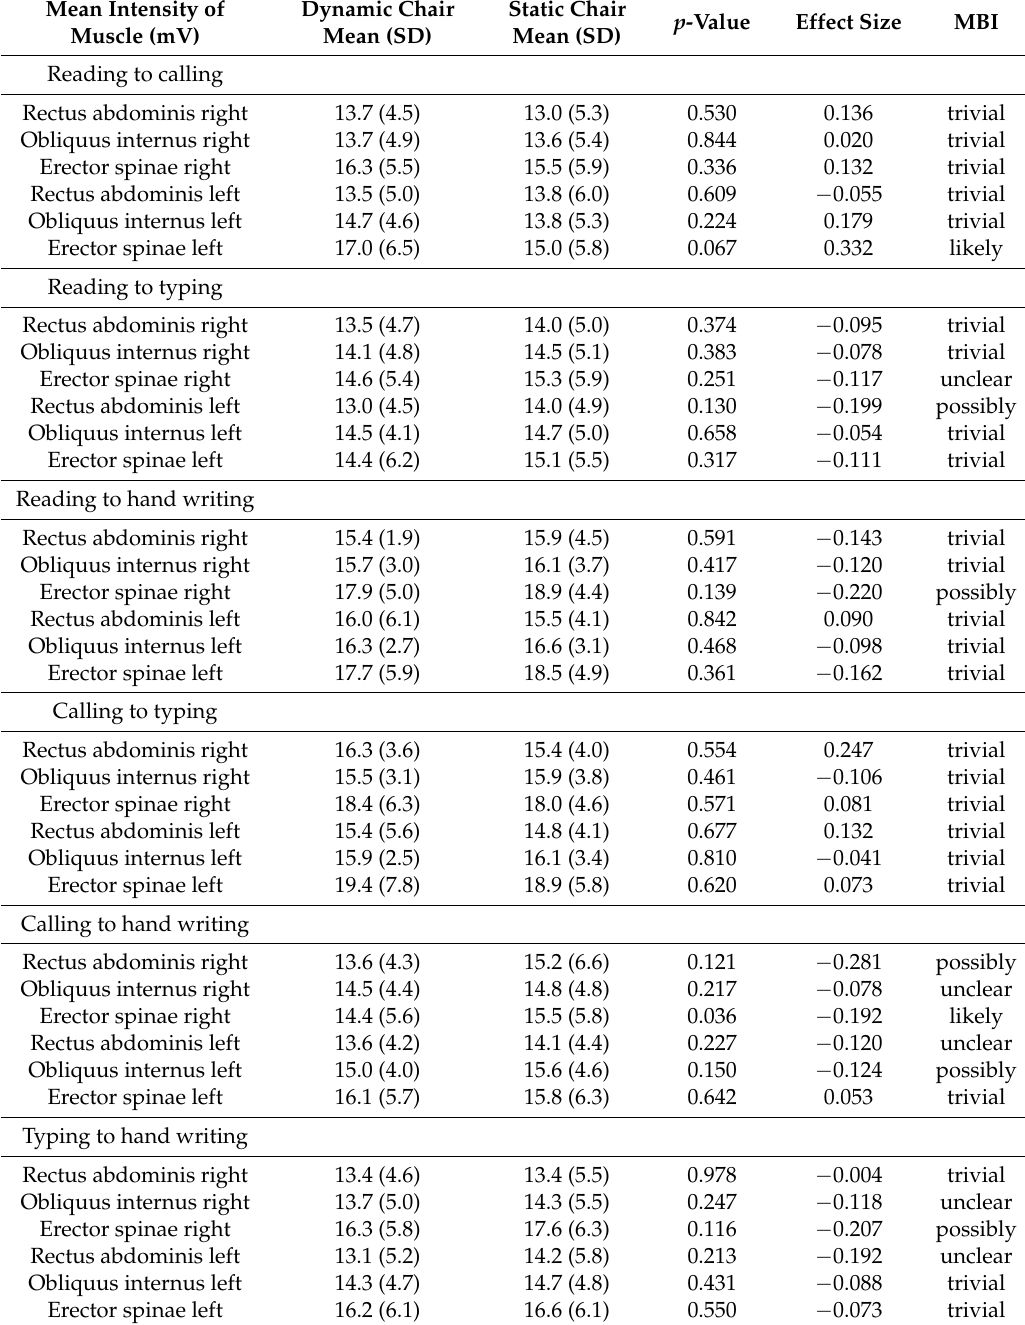
Table 3. Mean (SD) mean muscle intensity while sitting on the two chairs during the different task